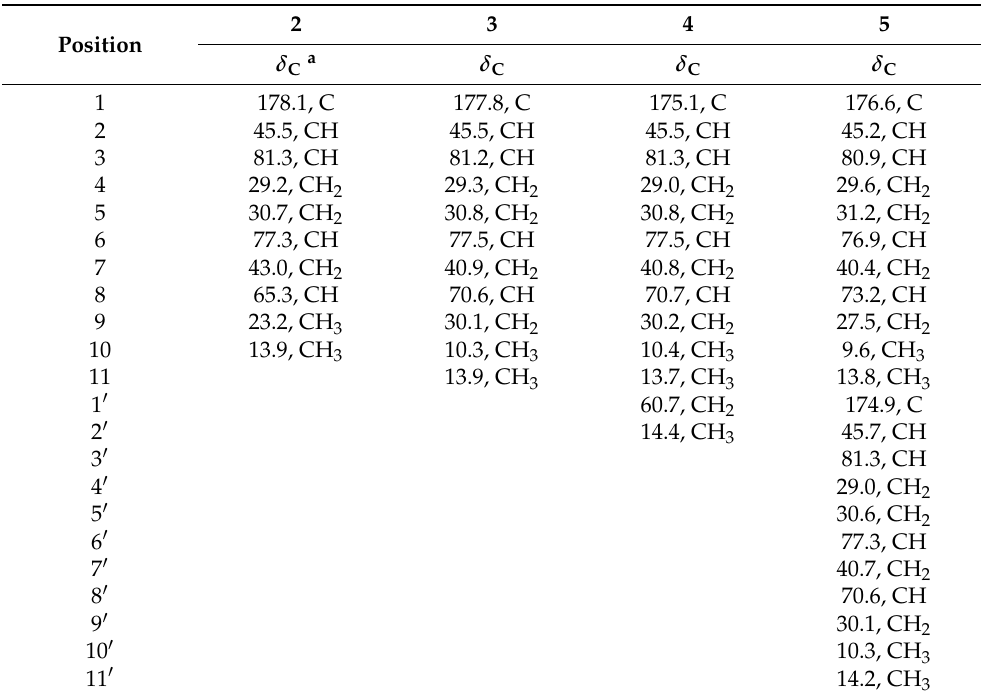
Table 3. 13 C NMR spectral data for 2 – 5 in CDCl 3